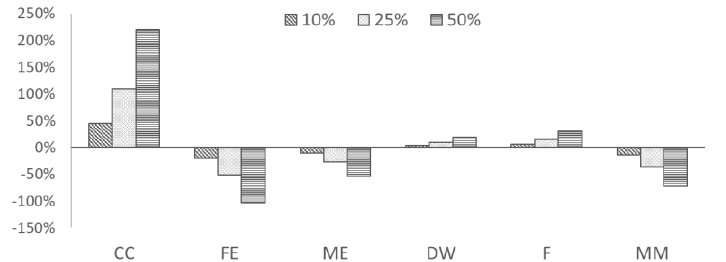
Figure 4. Net change for all impact categories with reduction in biomass yield in evapotranspiration DWWTS.